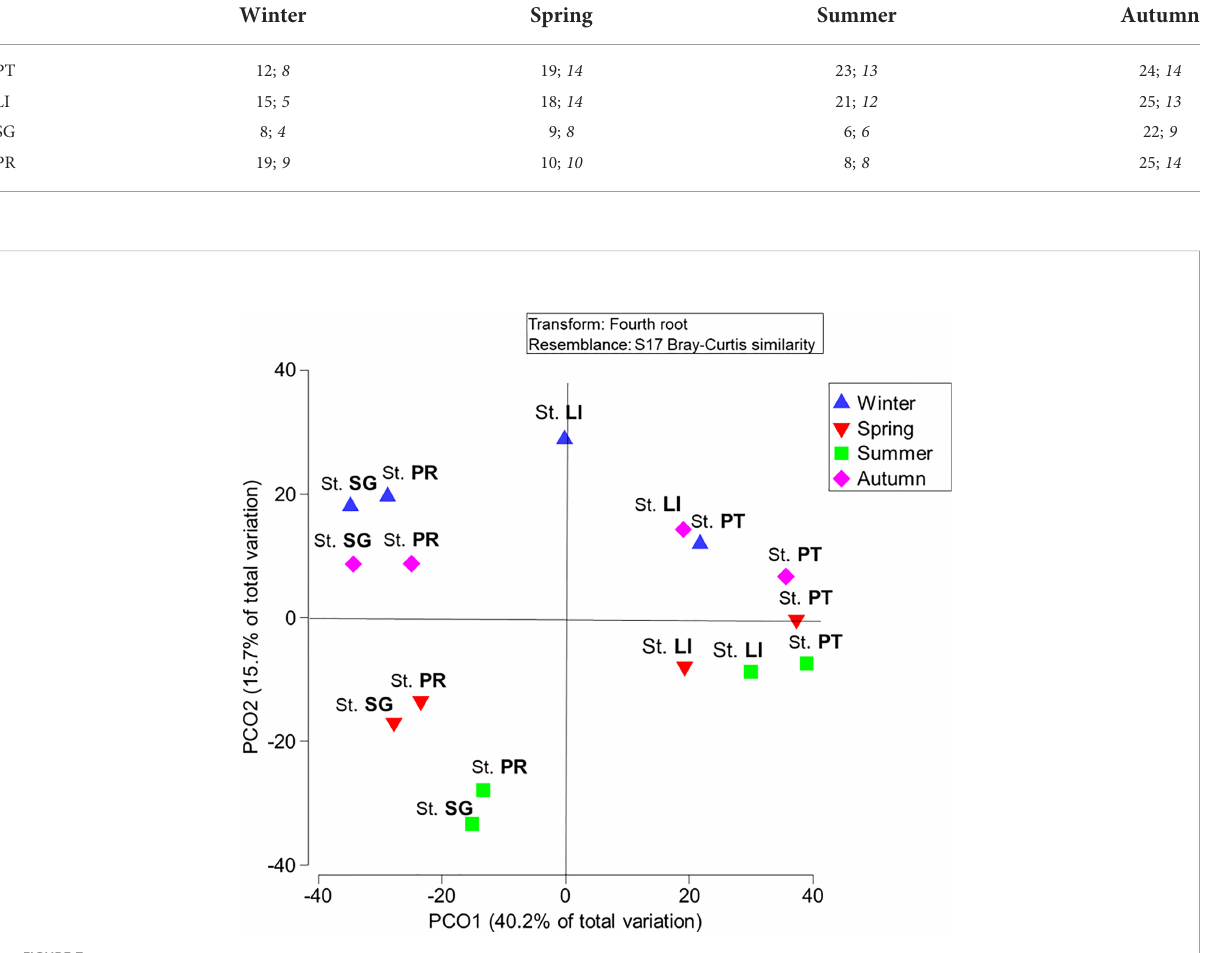
FIGURE 7 Biplot of samples (seasons and stations) based on PCoA of the phytoplankton taxa. St. SG, San Giuliano station; St. PR, Palude della Rosa station; ST LI, Lido station; St. PT, Platform